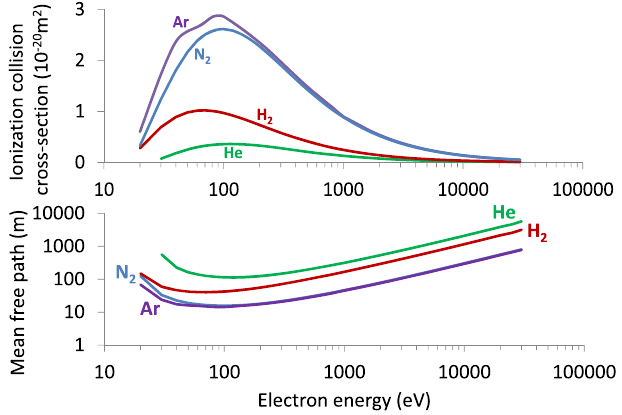
FIG. 9. Ionization collision cross sections and calculated mean-free path calculated at 10 − 2 Pa as functions of electron energy for Ar, N 2 , H 2 , and